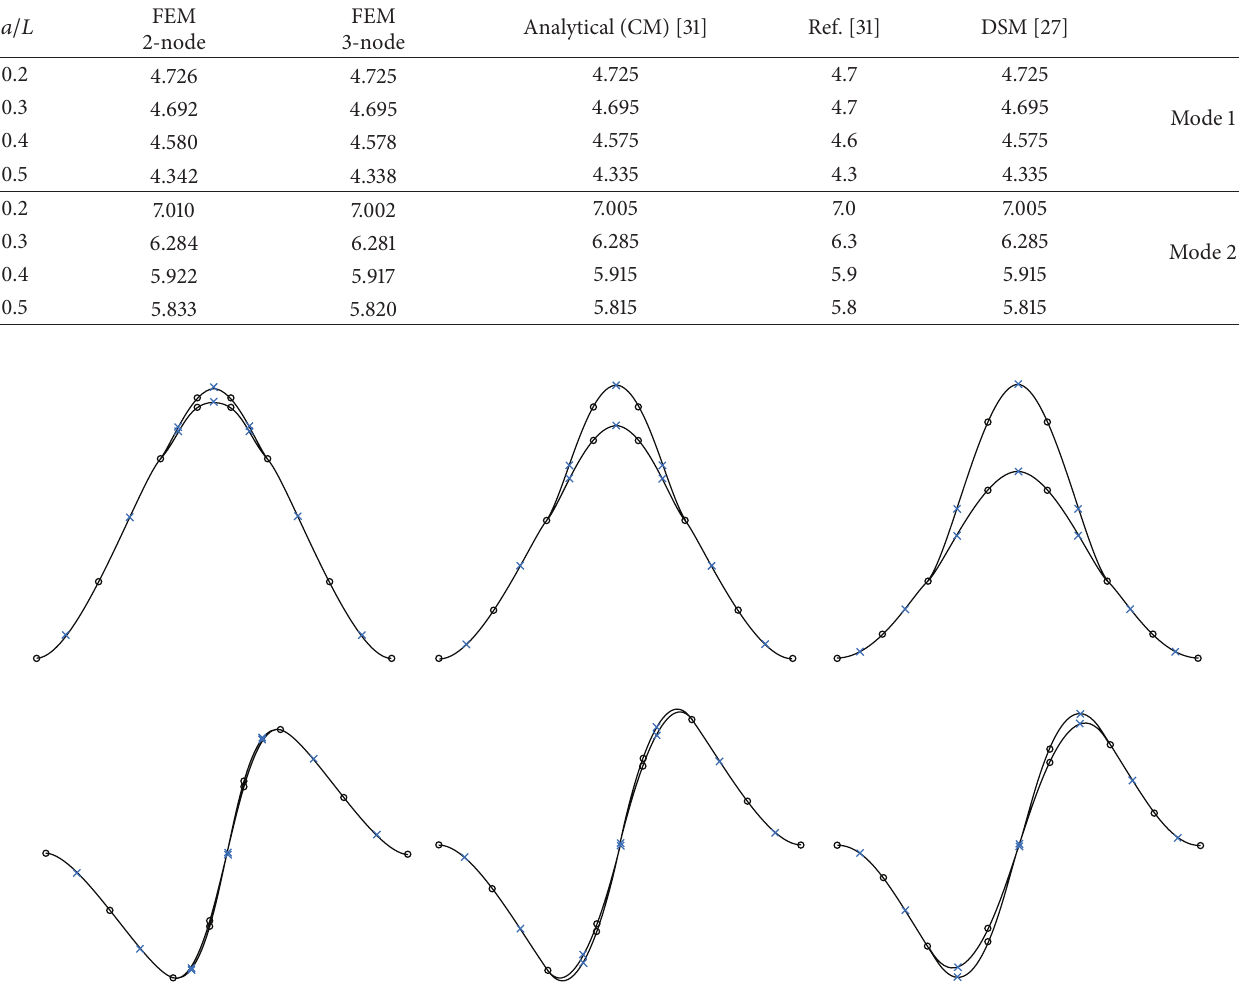
Figure 10: The first two natural modes for a 2-layered beam with centrally located delamination, obtained from Model 1; top: 1st mode shapes. Bottom: 2nd mode shapes; left: 30%, middle: 40%, and right 50%